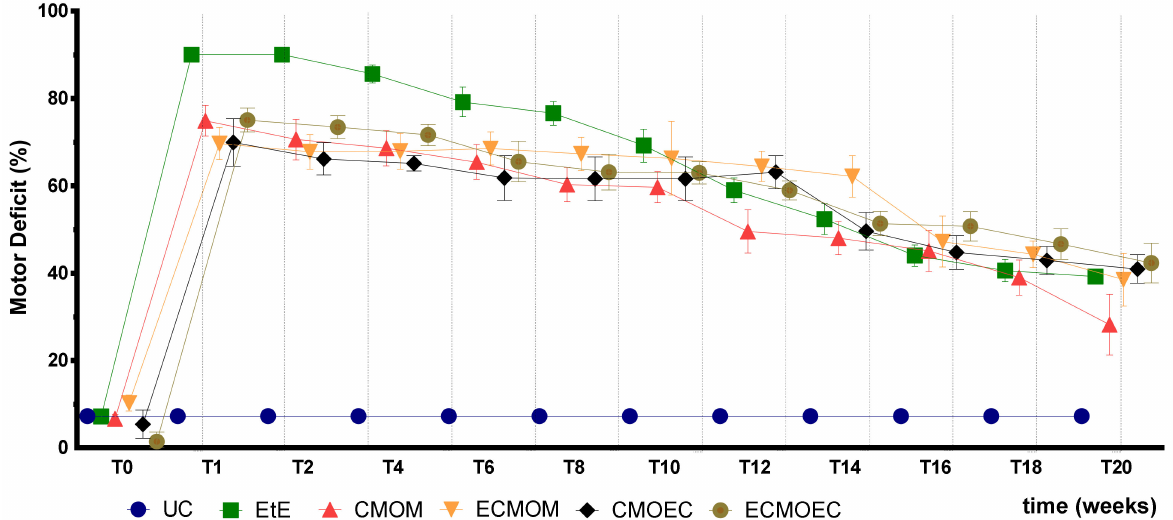
Figure 5. Values of motor deficit (%) over the 20 weeks of the recovery period (mean ± SEM). One week after the injury, all groups showed high percentages of motor deficit when compared to the UC group. Deficits gradually decreased over the study weeks, and at 20 weeks, the CMOM group showed the lowest value of motor